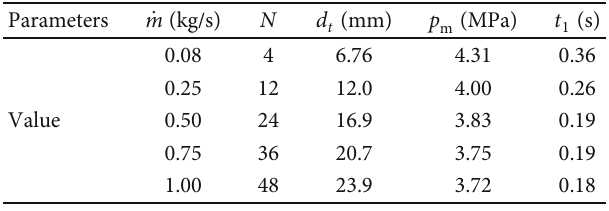
Figure 12: The pressure evolutions in the combustor for di ff erent mass fl ow rate of the pasty propellant. Table 7: The main parameters calculated results for di ff erent mass fl ow rates of the pasty propellant. Table 8 lists the main parameters of the calculated results.